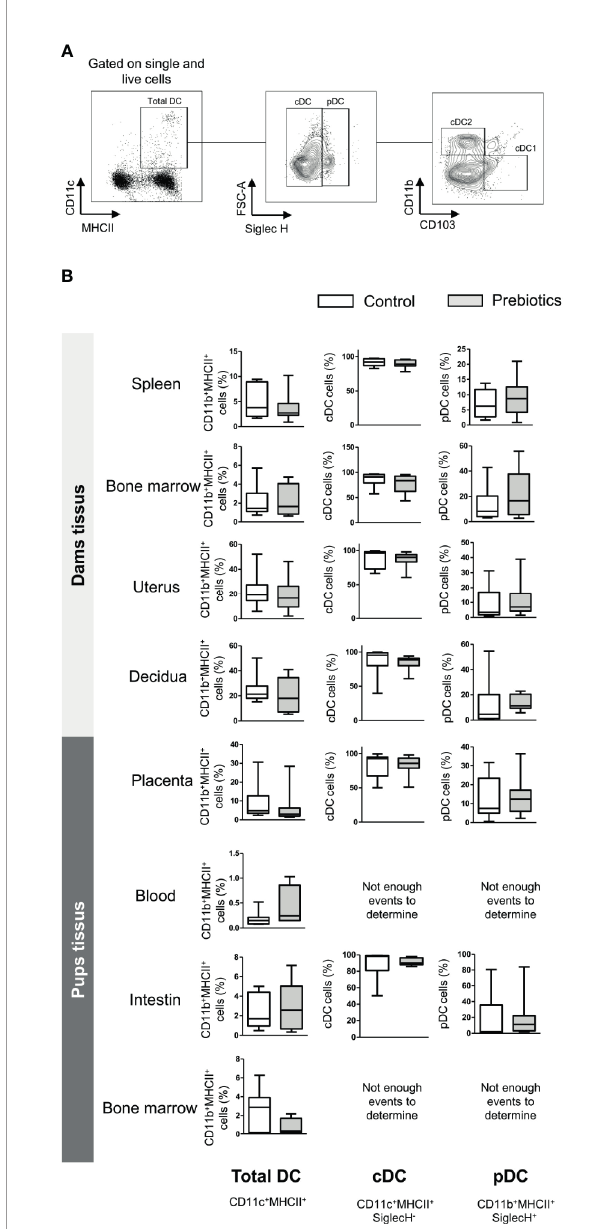
FIGURE 5 | Effects of GOS/inulin supplementation during pregnancy on dendritic cell frequency in dams and fetuses. (A) Gating strategy used after immunostaining to evaluate all DC subsets. (B) Assessment of total DC, conventional DC (cDC) and plasmacytoid DC (pDC) frequencies in tissues from dams and pups fed a control diet (white) or a diet supplemented with GOS/inulin (gray)